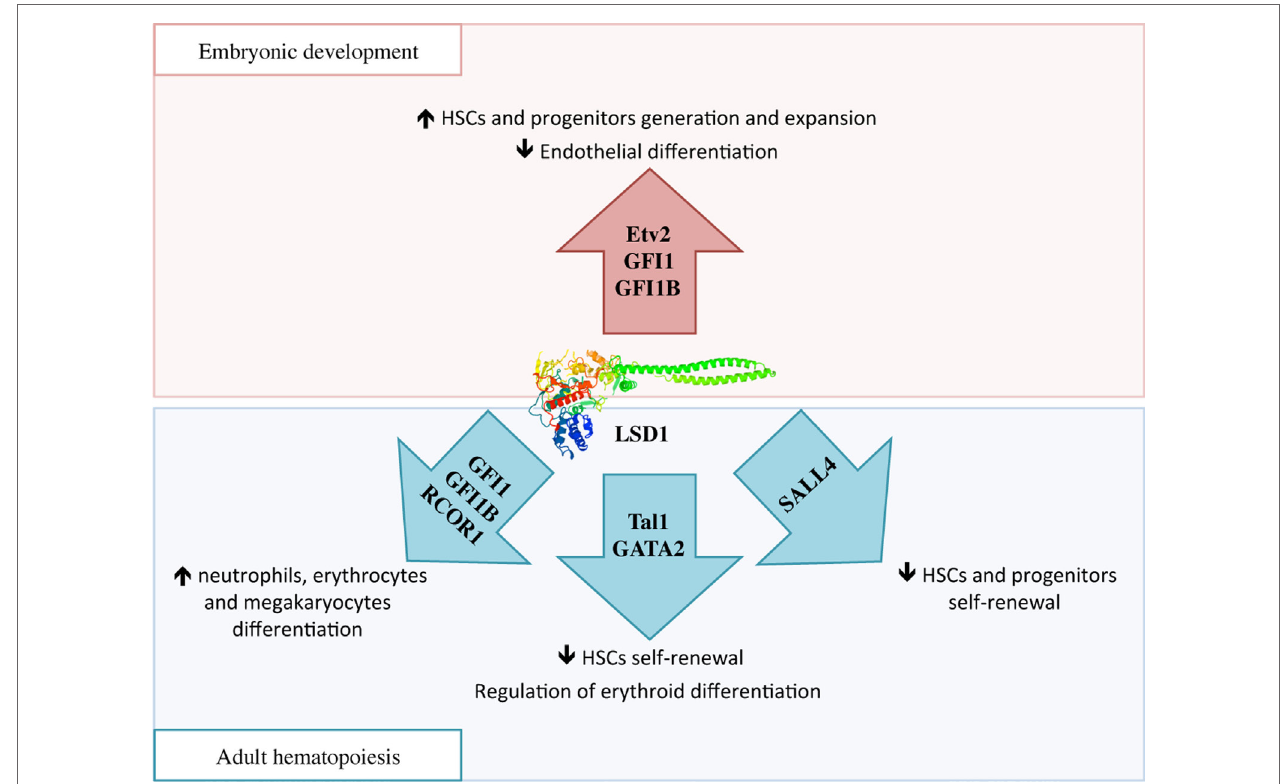
FigURe 3 | The complex function of lysine-specific demethylase 1A (LSD1) in hematopoiesis. During embryonic development, LSD1 promotes expansion and maturation of hematopoietic stem and progenitor cells by regulating Evt2 expression and downregulating genes involved in endothelial commitment through binding to GFI1 and GFI1B. In adult hematopoiesis, LSD1 limits hematopoietic stem cells self-renewal through Sal-like protein 4 and Tal1 binding; at the same time it promotes hematopoietic differentiation toward neutrophils, erythrocytes, and megakaryocytes through specific binding to RCOR1/CoREST and GFI1 and GFI1B. Moreover, LSD1–Tal1 complex regulates erythroid differentiation through GATA2 binding and expression of the Gata1 gene at different stages of